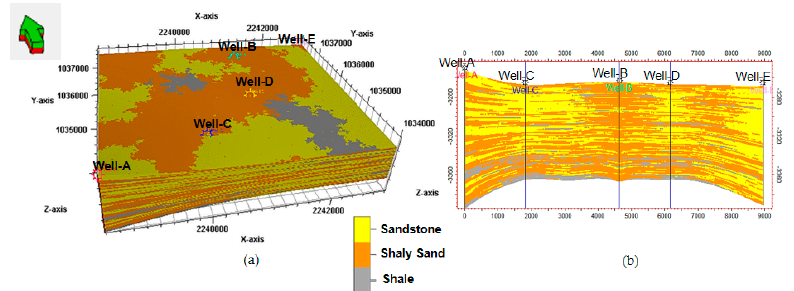
Figure 9. The petrophysical modeling and inversion of facies ( a ) 3D facies model, ( b ) cross-sectional view of the 3D facies model.